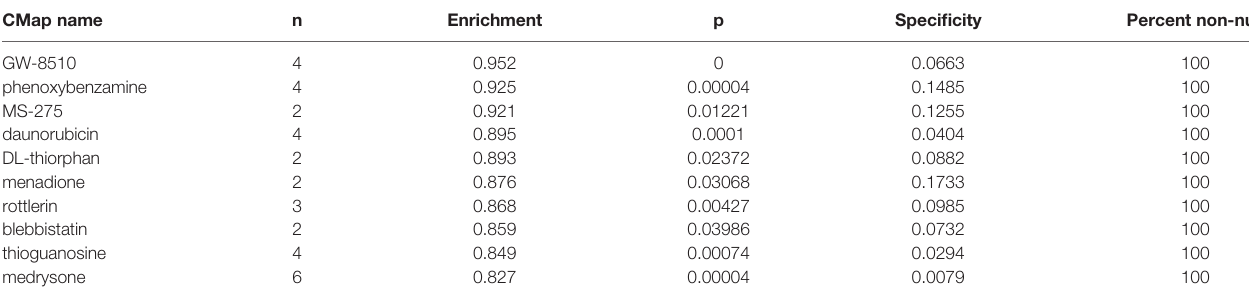
TABLE 1 | Potential effective small-molecule agents predicted by